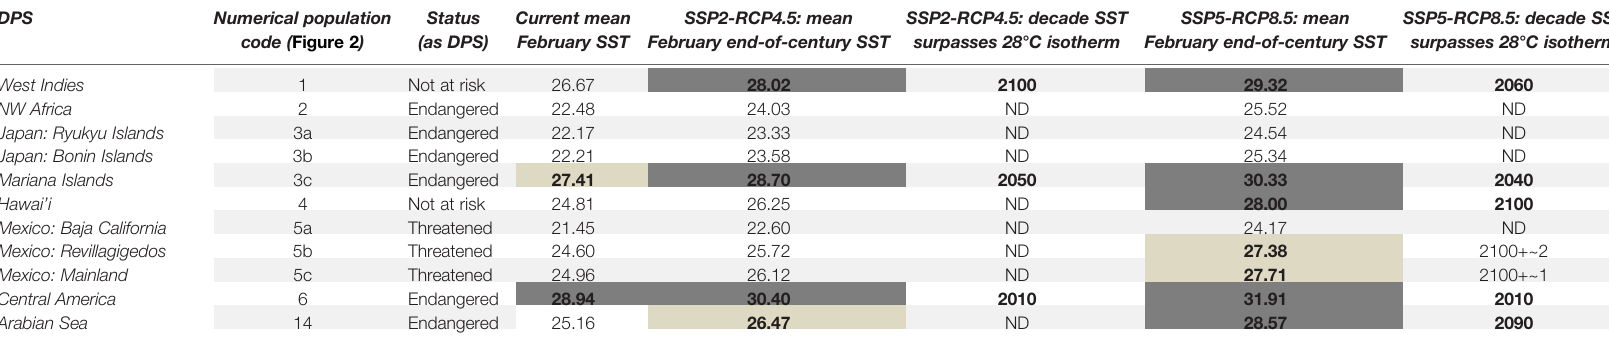
CurrentSSTsandprojectedSSTsundergreenhousegasemissionscenariosSSP2-RCP4.5andSSP5-RCP8.5aredisplayedtogetherwiththedecadeinwhicheachDPSareacouldsurpassthe28°Cisotherm(otherwiseND, ‘ notdetected ’ ).